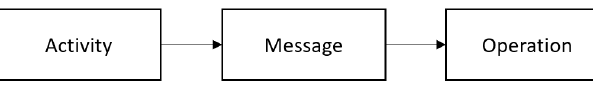
Figure 5. Structure of an activity.